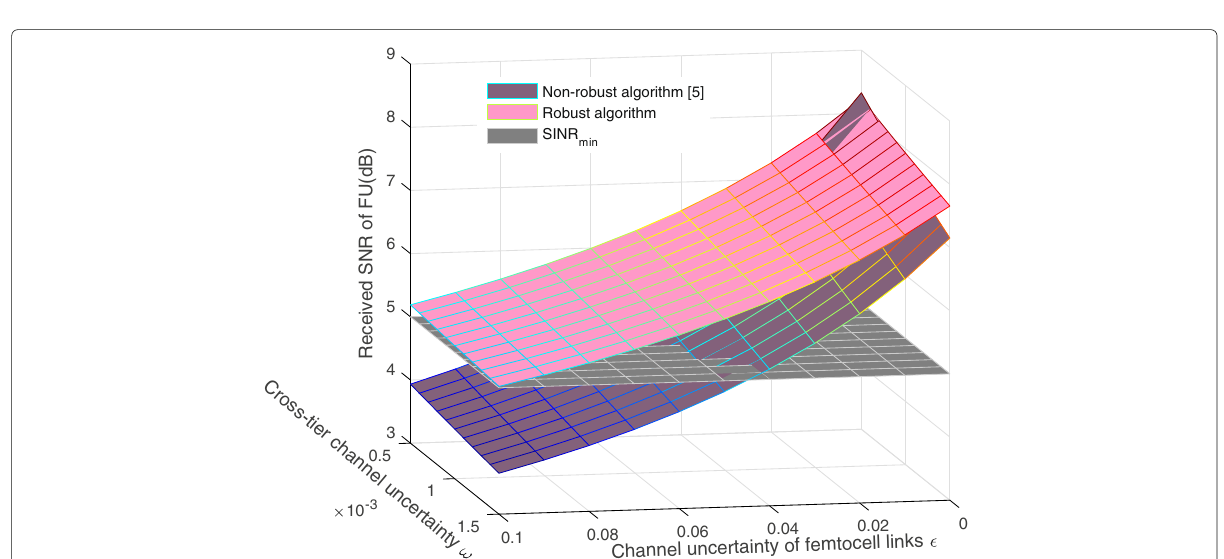
Fig. 8 SINR comparison of robust and non-robust algorithm under time-varying channel